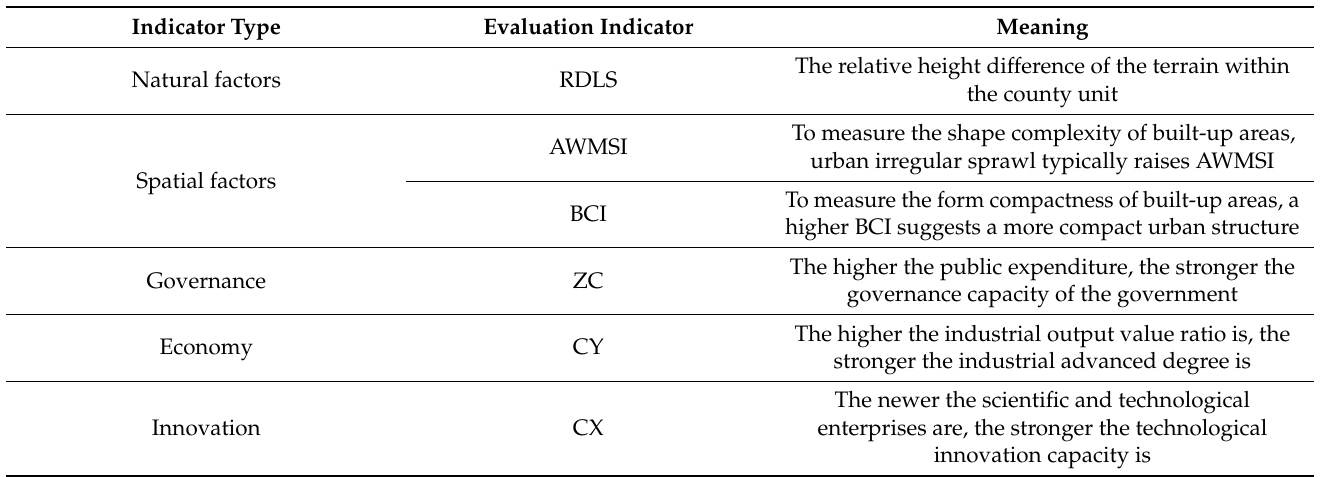
Table 4. Selection of driving